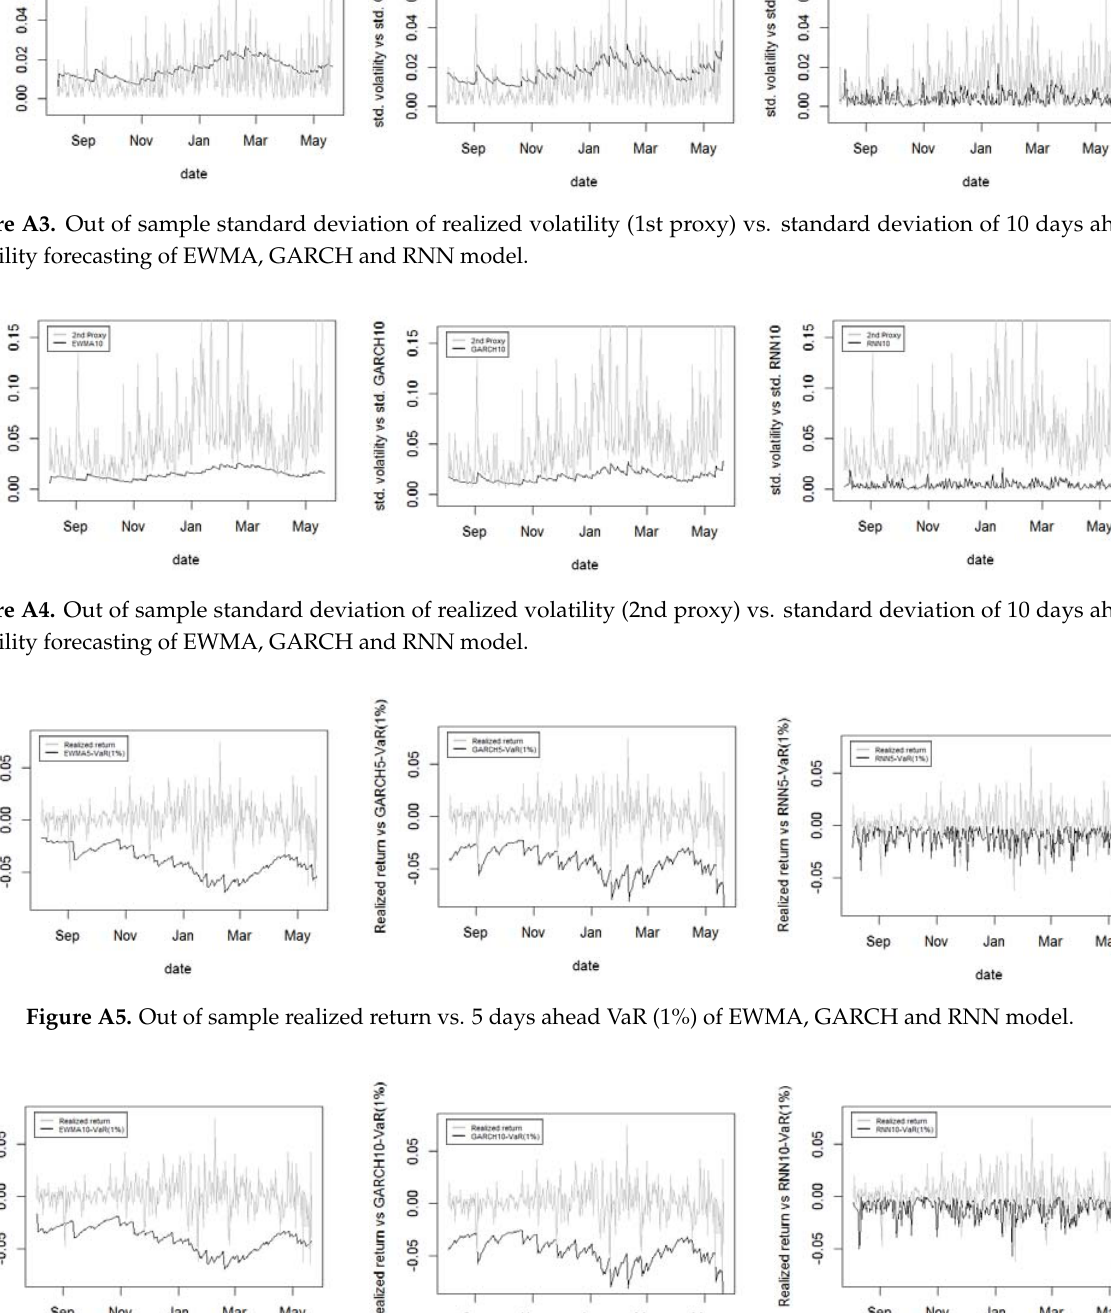
Figure 6. Out of sample realized return vs 10 days ahead VaR(1%) of EWMA, GARCH and RNN model